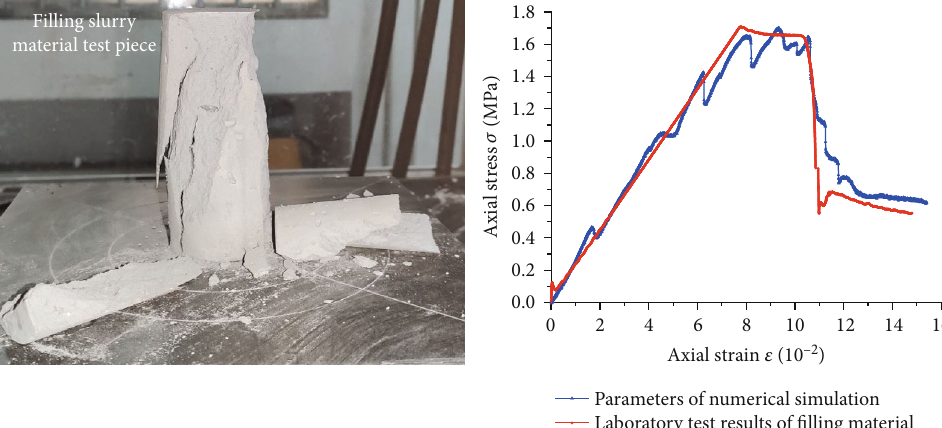
Figure 8: Calibration result of the fi lling material simulation